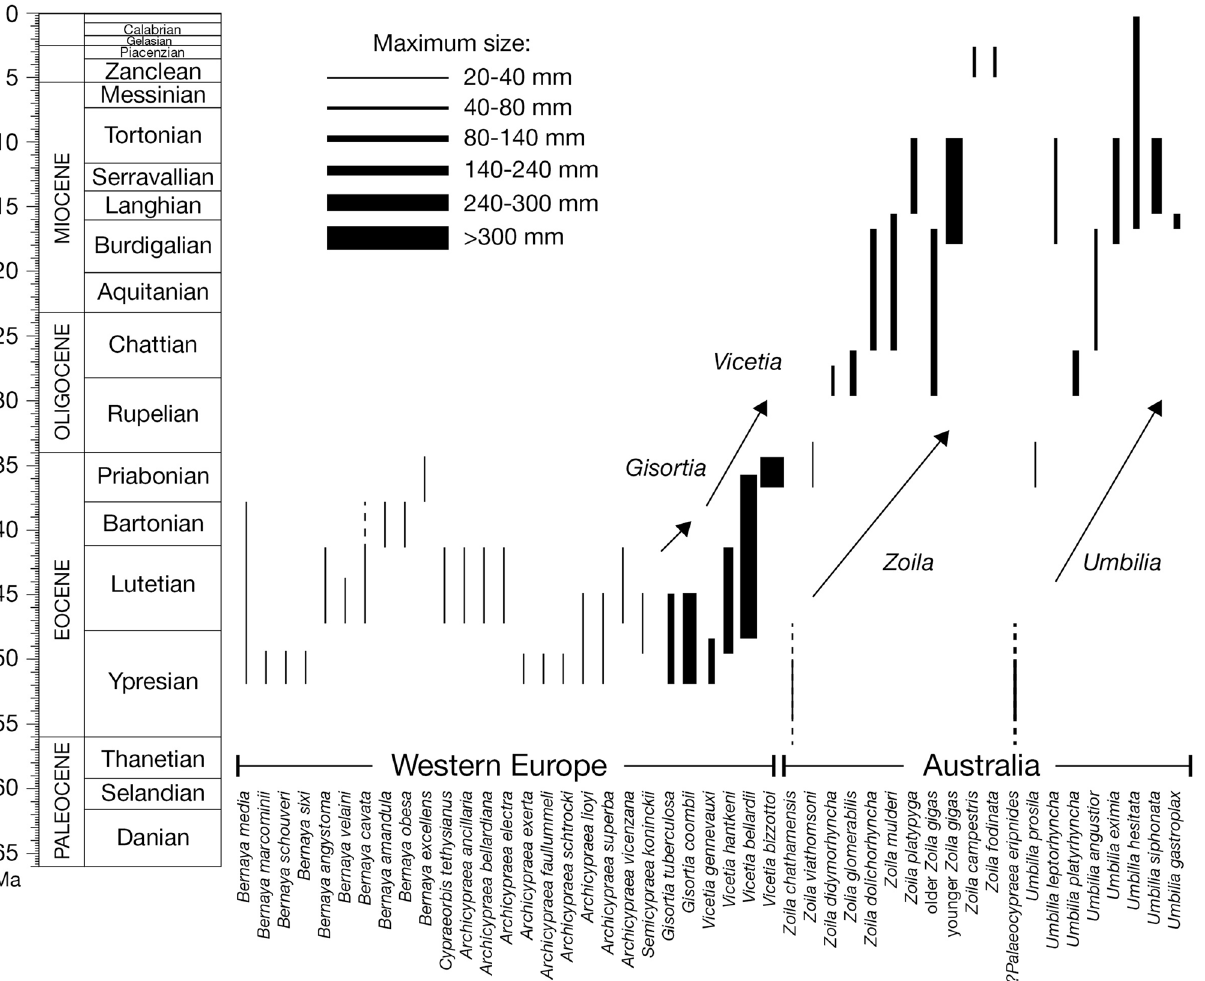
Figure 3. Stratigraphic range of Gisortiinae cypraeids in western Europe and genera Zoila and Umbilia in Australia. Maximum known shell size shown by line thickness. Arrows indicate trends in size increase recognised in successive species of four distinct